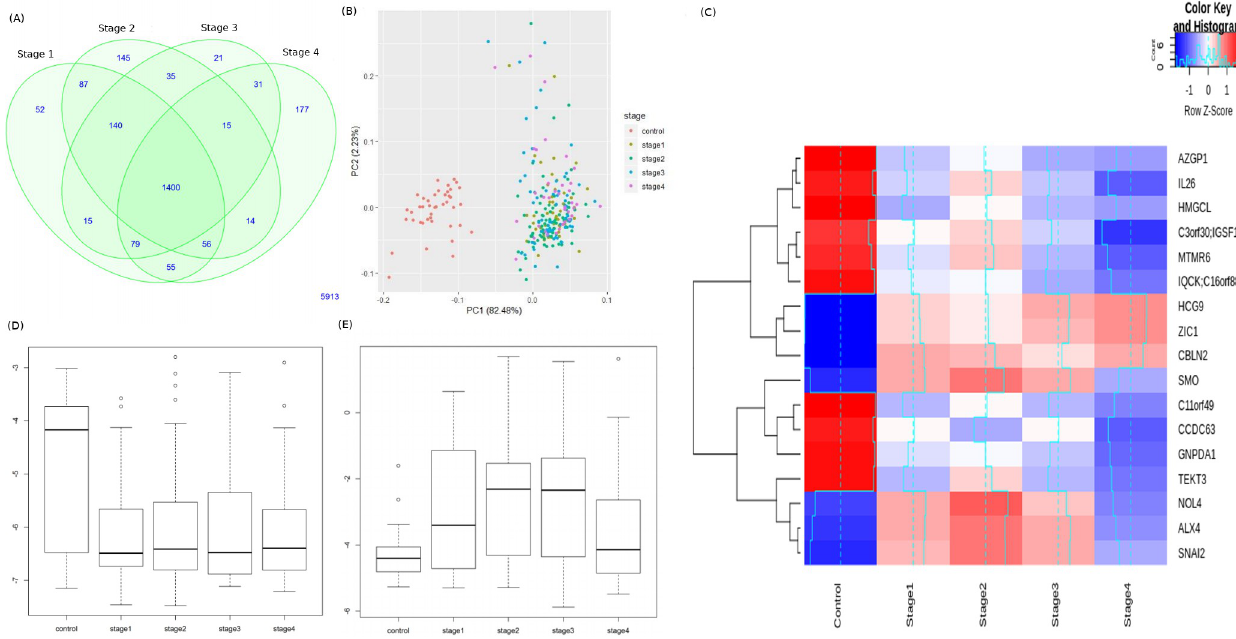
Fig 1. Linear modelling with M-value matrix, all probes. (A) Venn distribution of significant DM genes in each stage relative to control. (B) Distribution of samples based on the top two principal components of the top 100 genes shows a clear separation of cancer cases (labelled by stage) from controls. (C) Stagewise methylation portraits of the top four significant stage-specific DMGs. The contrast with the control is especially evident. Also shown are the stagewise methylation levels of (D) TMEM179, and (E) MEOX2.